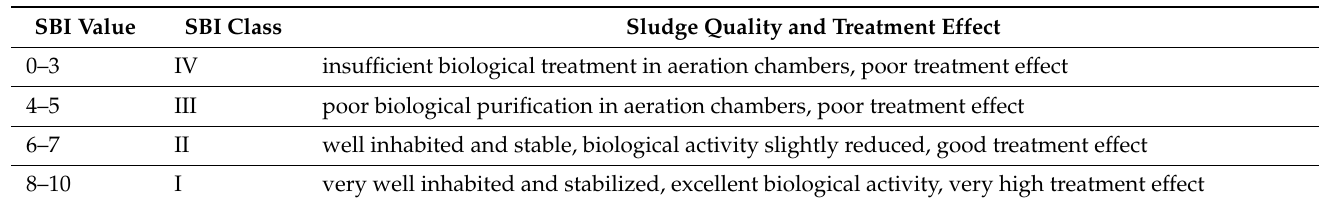
Table 4. Sludge biotic index (SBI) and its relation with treatment efficiency [11].